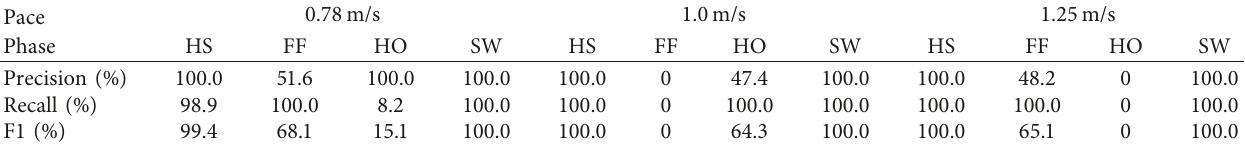
Table 3: Summary of classification performance of bagging at unsynchronized speed.